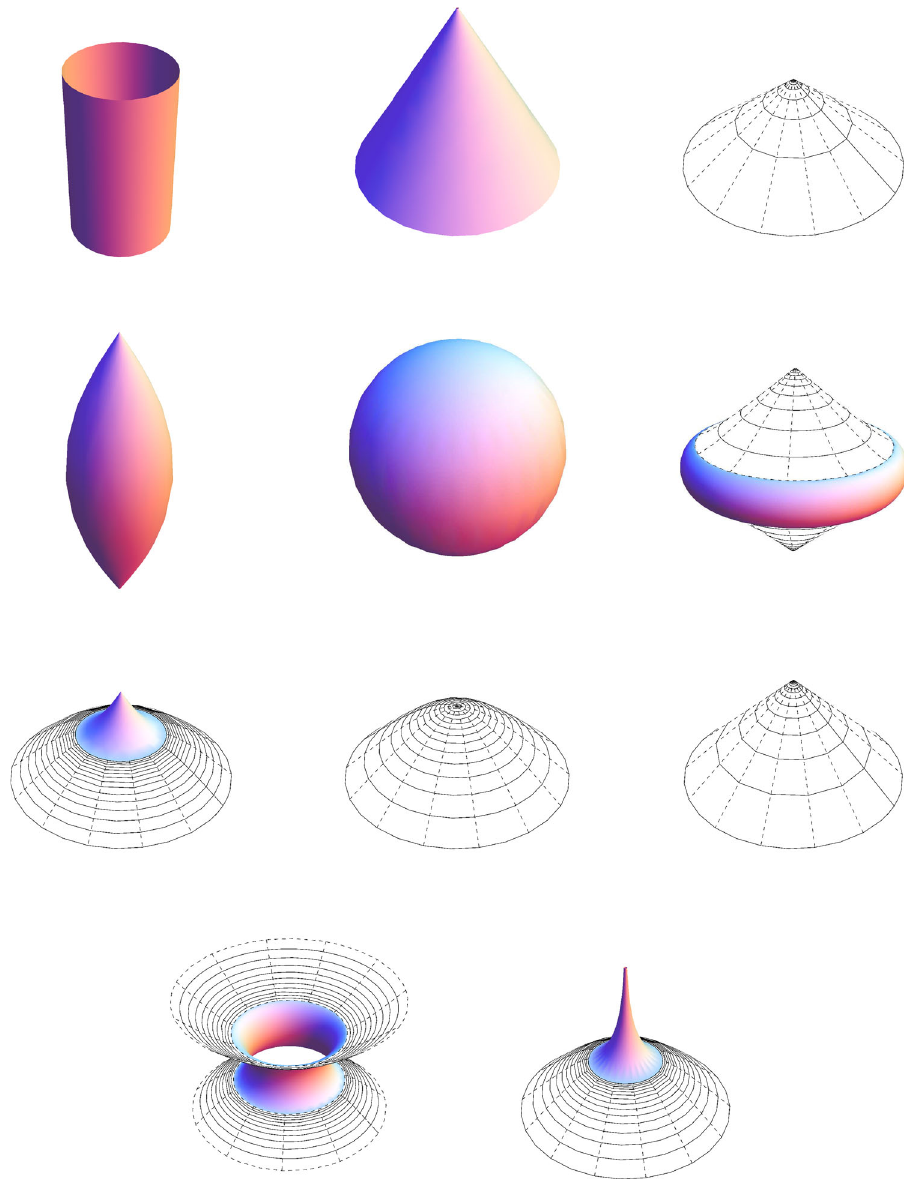
Fig. 1 Illustrations of constant time slices of the solutions in Sect. 4 assuming 0 ≤ θ < 2 π . Colored surfaces (or colored patches) without meshes are embedded in the Euclidean space, whereas uncolored surfaces (or uncolored patches) with meshes are embedded in the Minkowski space. The first row plots solutions of type A with | 1 + a 3 | = 0 , 0 . 5 , 2 from left to right, the second row is for type B solutions with | a | = 0 . 5 , 1 , 2 from left to 5 right, the third row corresponds to solutions of type C with | a | = 0 . 5 , 1 , 2 from left to 5 right, and subfigures in the fourth row depict type D (left) and type E (right) solutions. The constant time slices for type A solutions with | 1 + a 3 | = 1 is an Euclidean plane (not shown in this figure). In the subfigure for type E solutions, the spike extends to